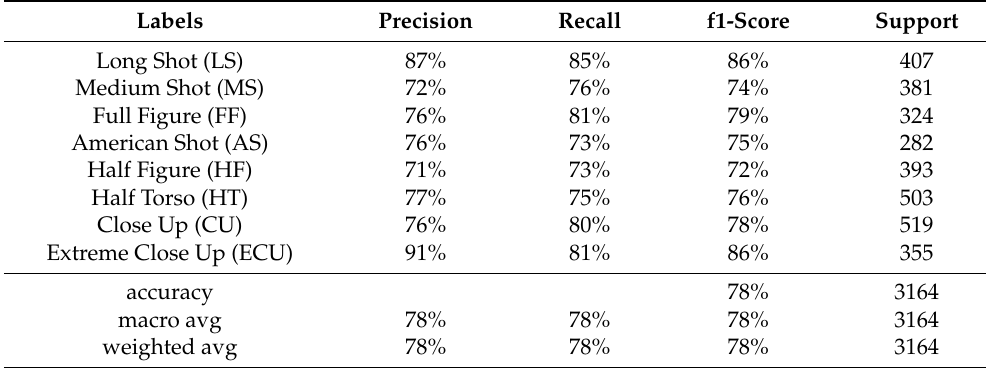
Table 24. Precision recall and f1-score of a mlp as fourth classifier trained on the predictions of three VGG-16 trained on each dataset with data augmentation techniques .